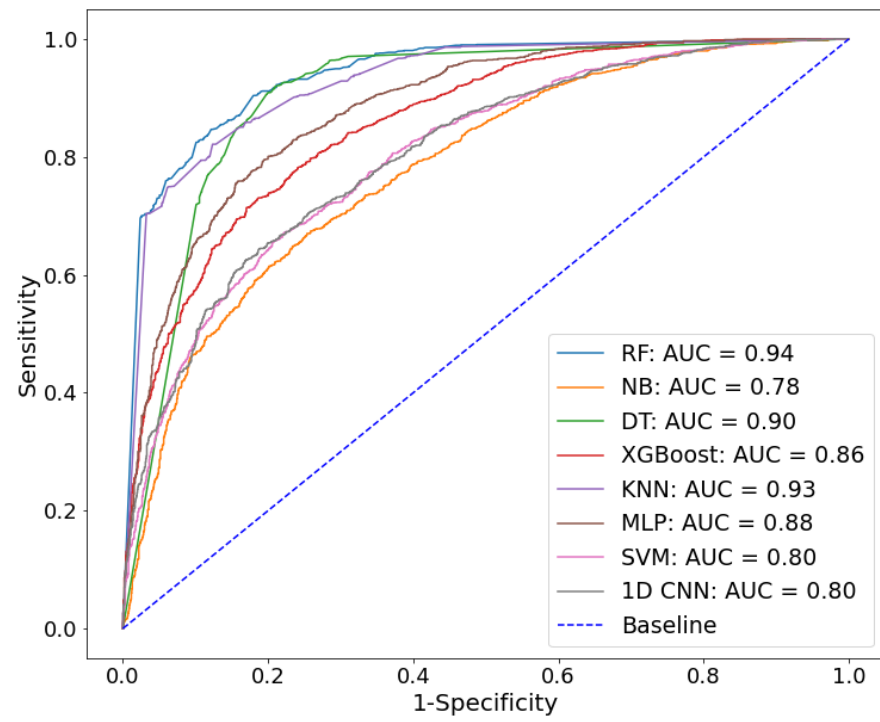
Figure 1. ROC curves of eight ML-based classifiers for children with